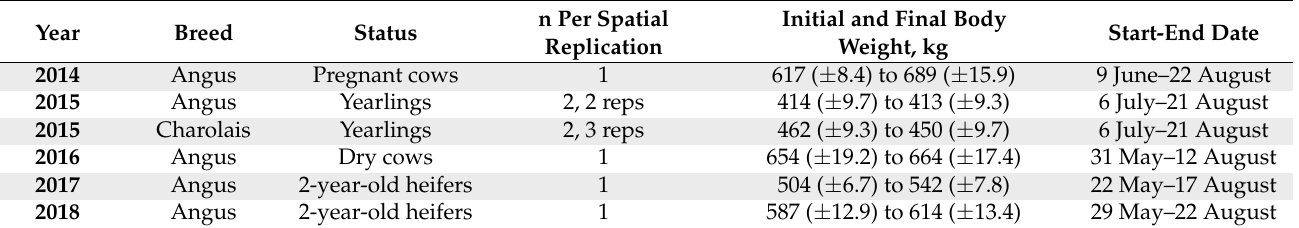
Table 1. Details of cattle used in the grazing study along with grazing start and end dates. Values for 2017 and 2018 include the confinement